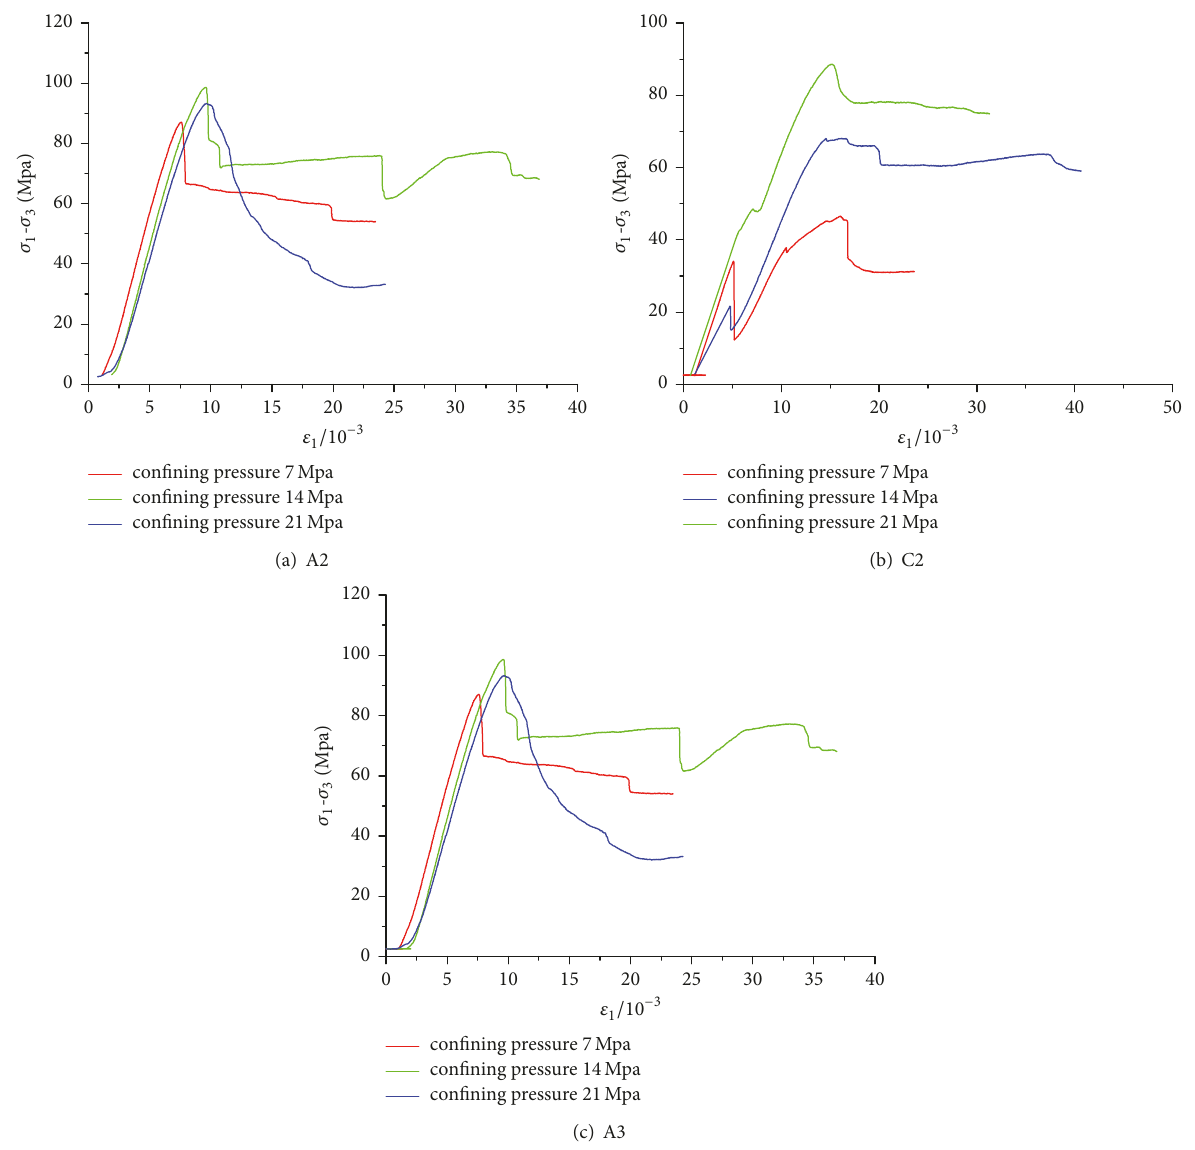
Figure 3: Axial stress-strain curves of single jointed